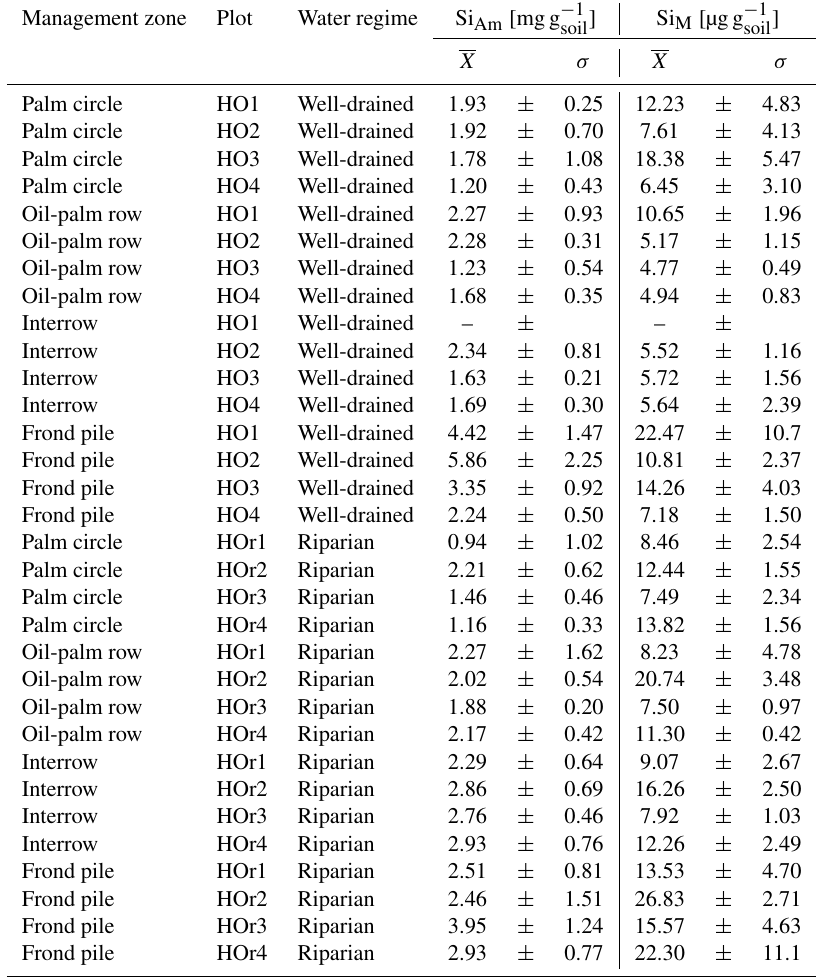
Table B1. Mean topsoil Si concentrations in different management zones of oil-palm plantations. Management